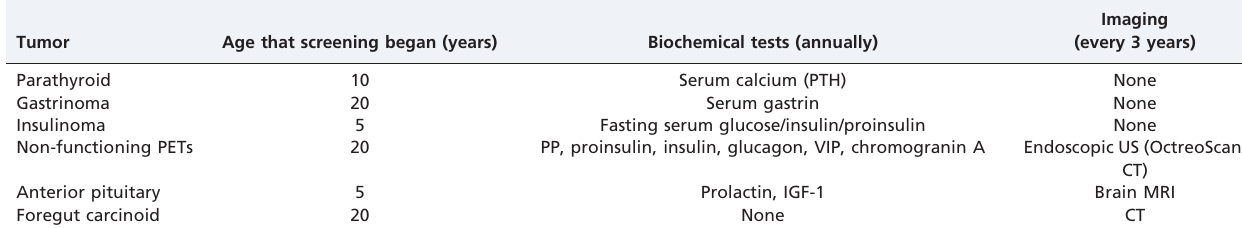
Table 1 - MEN1 screening. Revised from Brandi et al